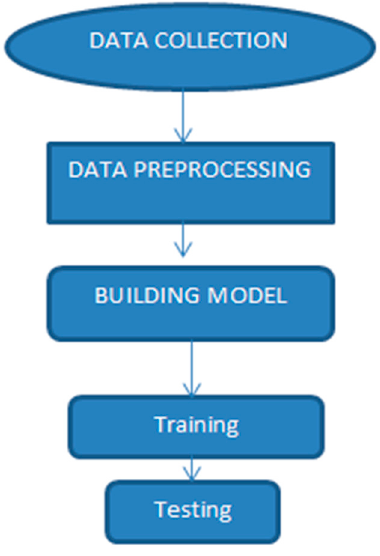
Figure 2. Proposed approach sequence of actions.